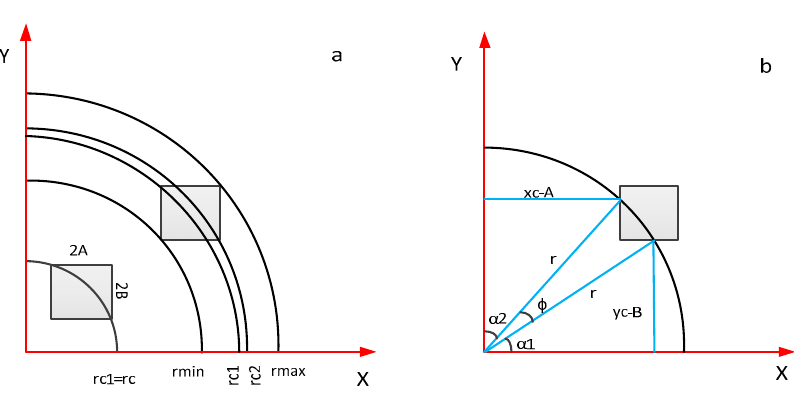
Figure 7. Geometry of a square detector for the o ff -axis positions in the focal plane: ( a ) di ff erent sites of the detector; ( b ) the arc segmented by the detector.